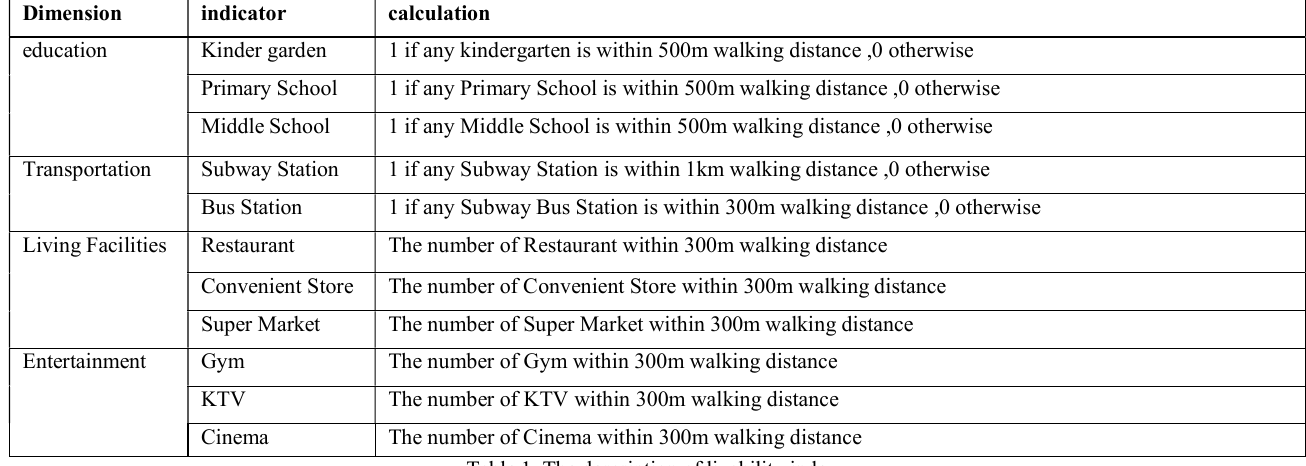
Table 1. The description of livability index